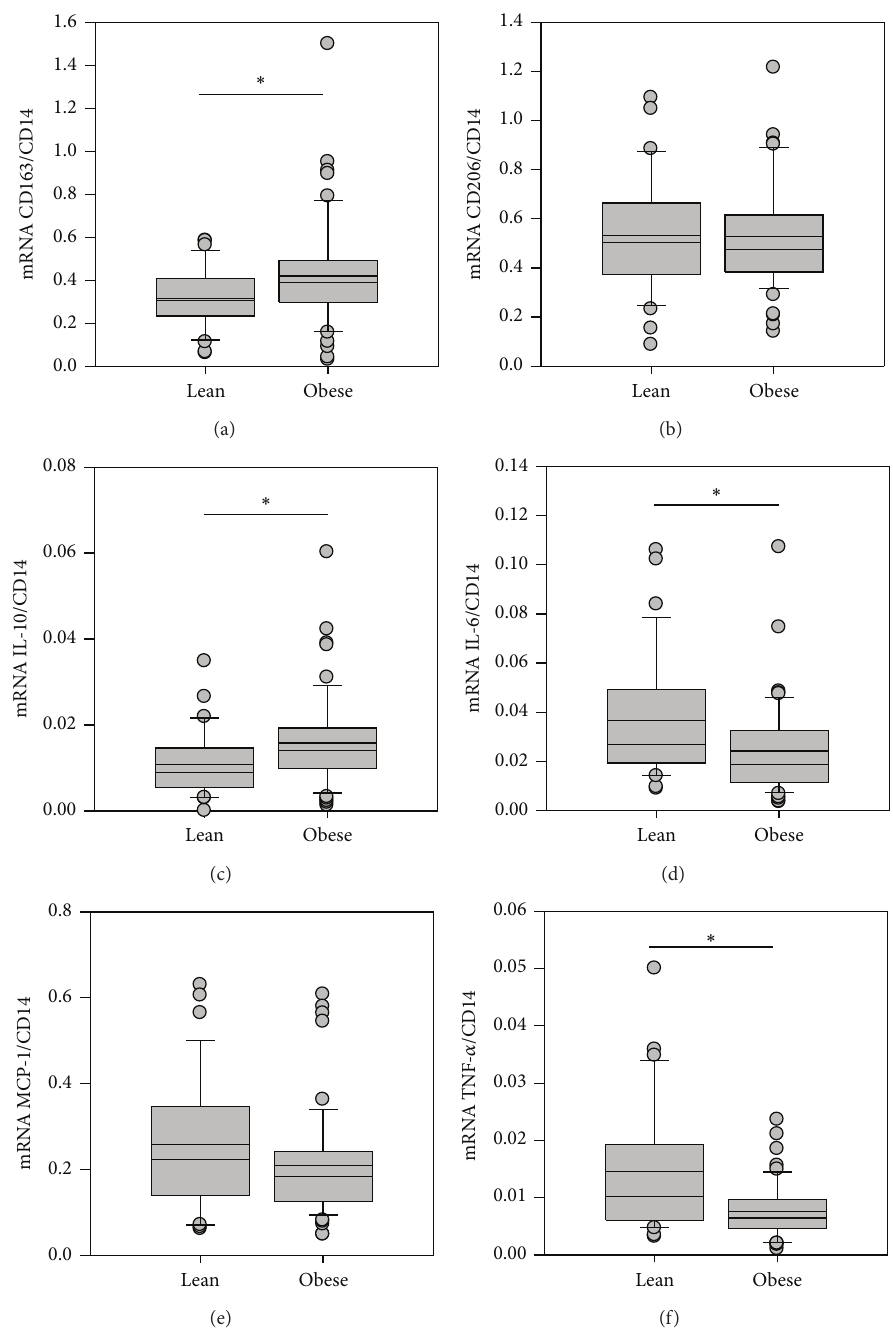
Figure 2: Polarization of anti- and proinflammatory macrophage markers in lean and obese subjects. Difference in phenotype of macrophage markers is expressed in subcutaneous abdominal adipose tissue samples from lean ( 𝑛 = 35 ) and obese ( 𝑛 = 57 ) subjects. Gene-expression levelsofmacrophagemarkersarepresentedrelativetoCD14,measuredbyRT-PCR.LeanversusobeseanalyzedbyaWilcoxonMann-Whitney rank sum test. The ratio between the anti-inflammatory markers CD163, CD206, and IL-10 ((a)–(c)). The ratio between the proinflammatory markers IL-6, MCP-1, and TNF- 𝛼 ((d)–(f)). ∗ 𝑃 < 0.05 . Graph showing each outliner and mean value with a solid line.